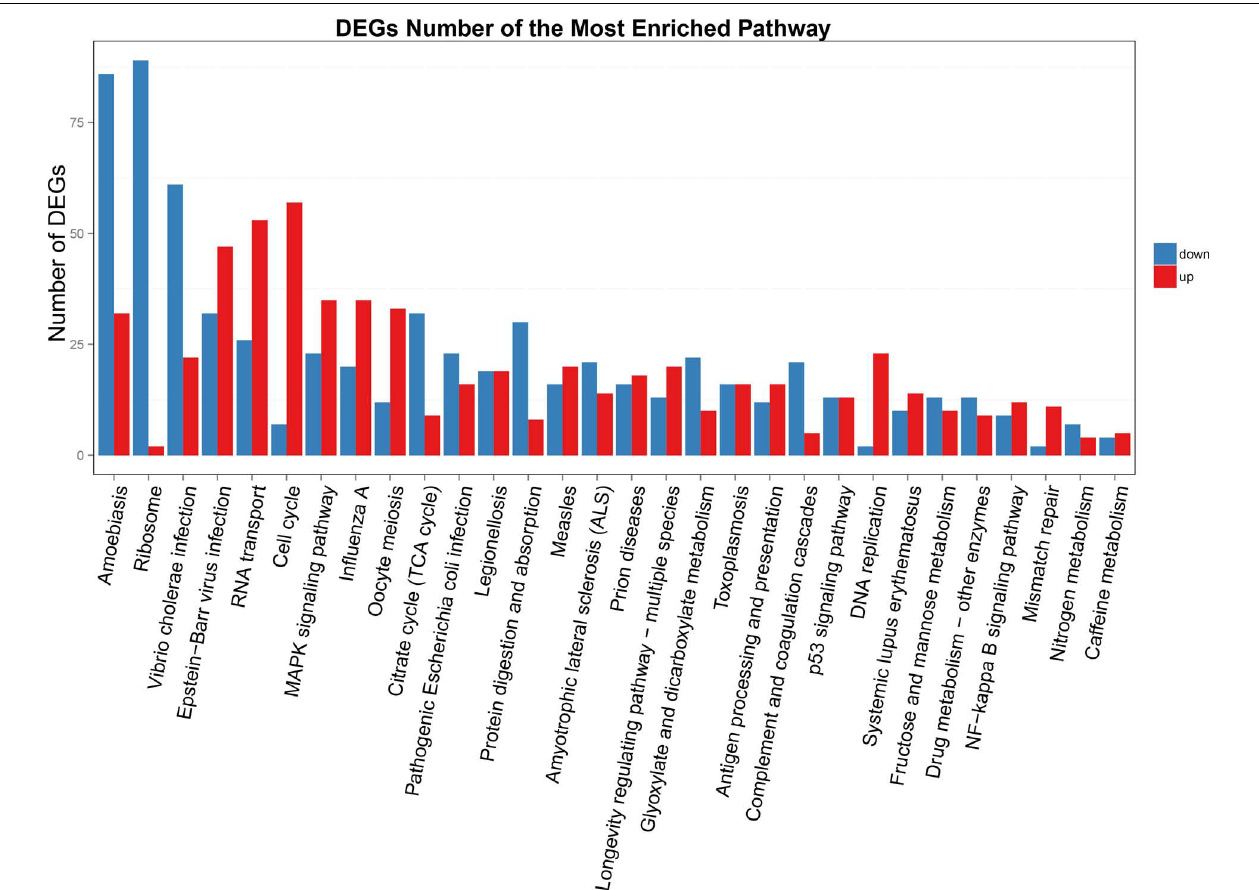
FIGURE 3 | KEGG enrichment analyses of DEGs. The X -axis indicates KEGG pathway entries, and the Y -axis indicates the number of the DEGs. The red bar indicates up-regulated genes, and the blue bar indicates down-regulated genes.